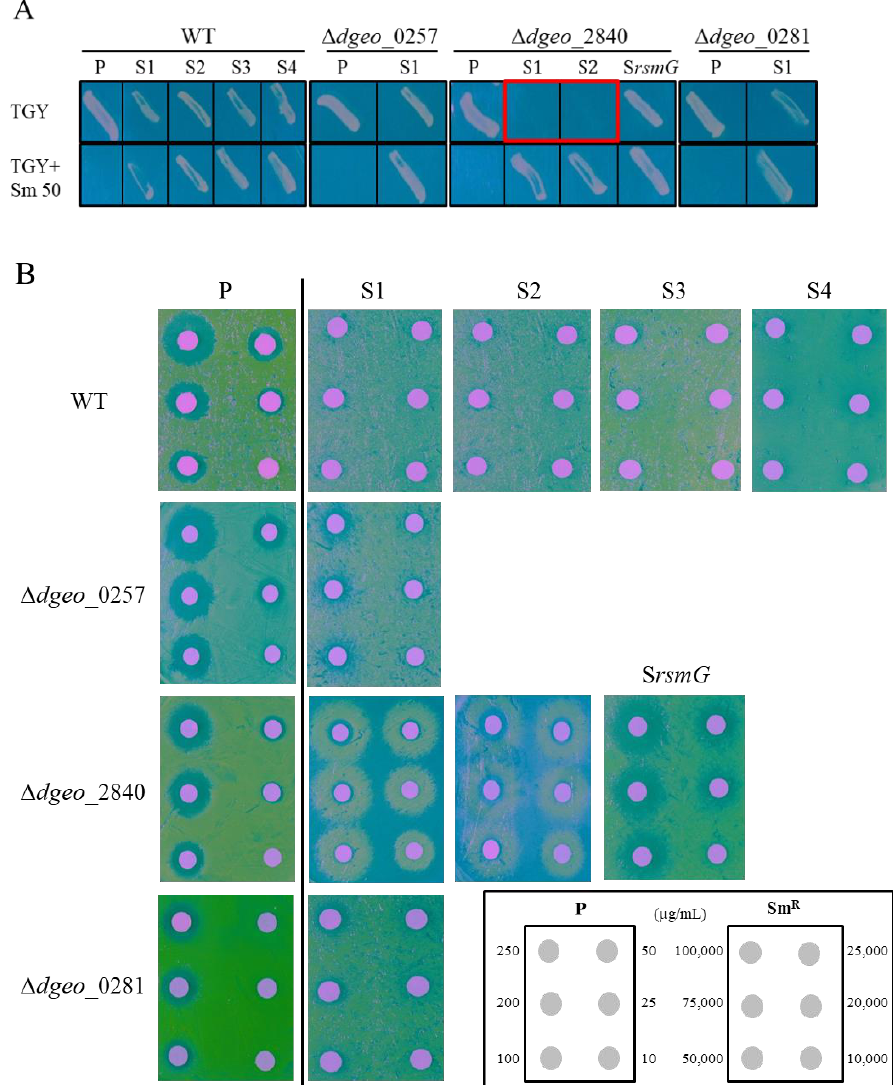
Figure 1. The selection of streptomycin-resistant (SmR) and -dependent (SmD) clones by chronic oxidative stress of wild-type, Δ dgeo _0257, Δ dgeo _0281, and Δ dgeo _2840 parent strains. ( A ) Growth comparison on TGY medium containing 50 µg/mL streptomycin among parent (P) and mutant (S1–S4 and rsmG ) strains. The red box indicates an Sm-dependent phenotype. ( B ) Minimum inhibitory concentration (MIC) values using the disc diffusion method for all selected mutants within the range of 10 to 250 µg/mL streptomycin for parent strains and 10,000 to 100,000 µg/mL streptomycin for Sm-resistant mutant strains on TGY medium.